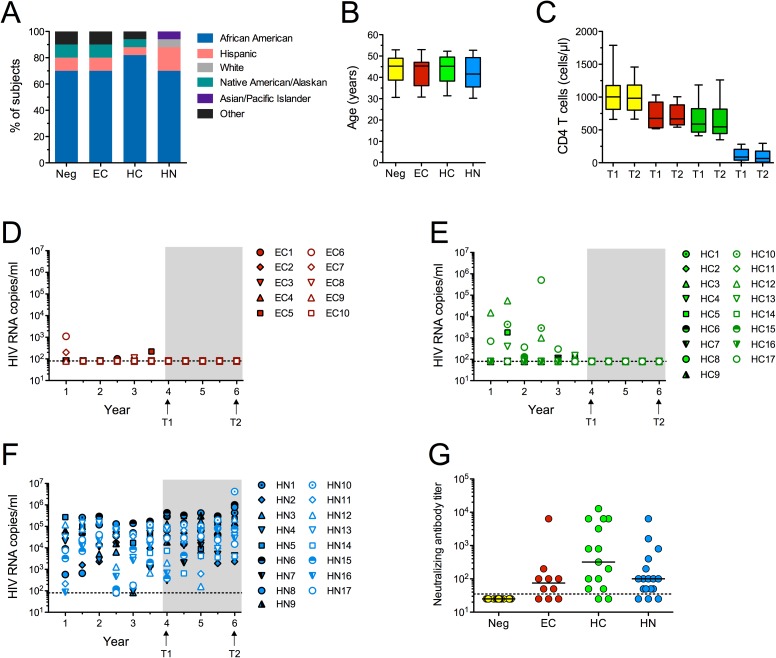
Characteristics of the study populations.Shown for each group of women enrolled in the study is the (A) racial composition, (B) age at the first time point (T1) of the study, and (C) CD4 T cell counts in blood at T1 and roughly 2 years later (T2). Whiskers in the box plots denote minimum to maximum values. The CD4 T cell counts in EC and HC did not differ significantly, and although they were lower than Neg controls (both p < 0.02), they were within the normal range (500-1500/μl). (D-F) Plasma viremia was measured by the WIHS at rough 6 month intervals and is shown for subjects starting 3 years before T1 and during the next 2 years. All VLs shown for HN and HC were measured while the subjects were on HAART. The dashed line represents the limit of detection in the PCR assay. (G) Neutralization of Clade C HIVQZ4589 (Trinidad) at T1 was measured using the TZM-bl assay. Data are expressed as the last reciprocal dilution of serum able to inhibit infection by 50%. Bars denote medians. Samples under the dashed line did not neutralize at the 1/50 starting dilution. No significant differences were found between any of the infection groups.